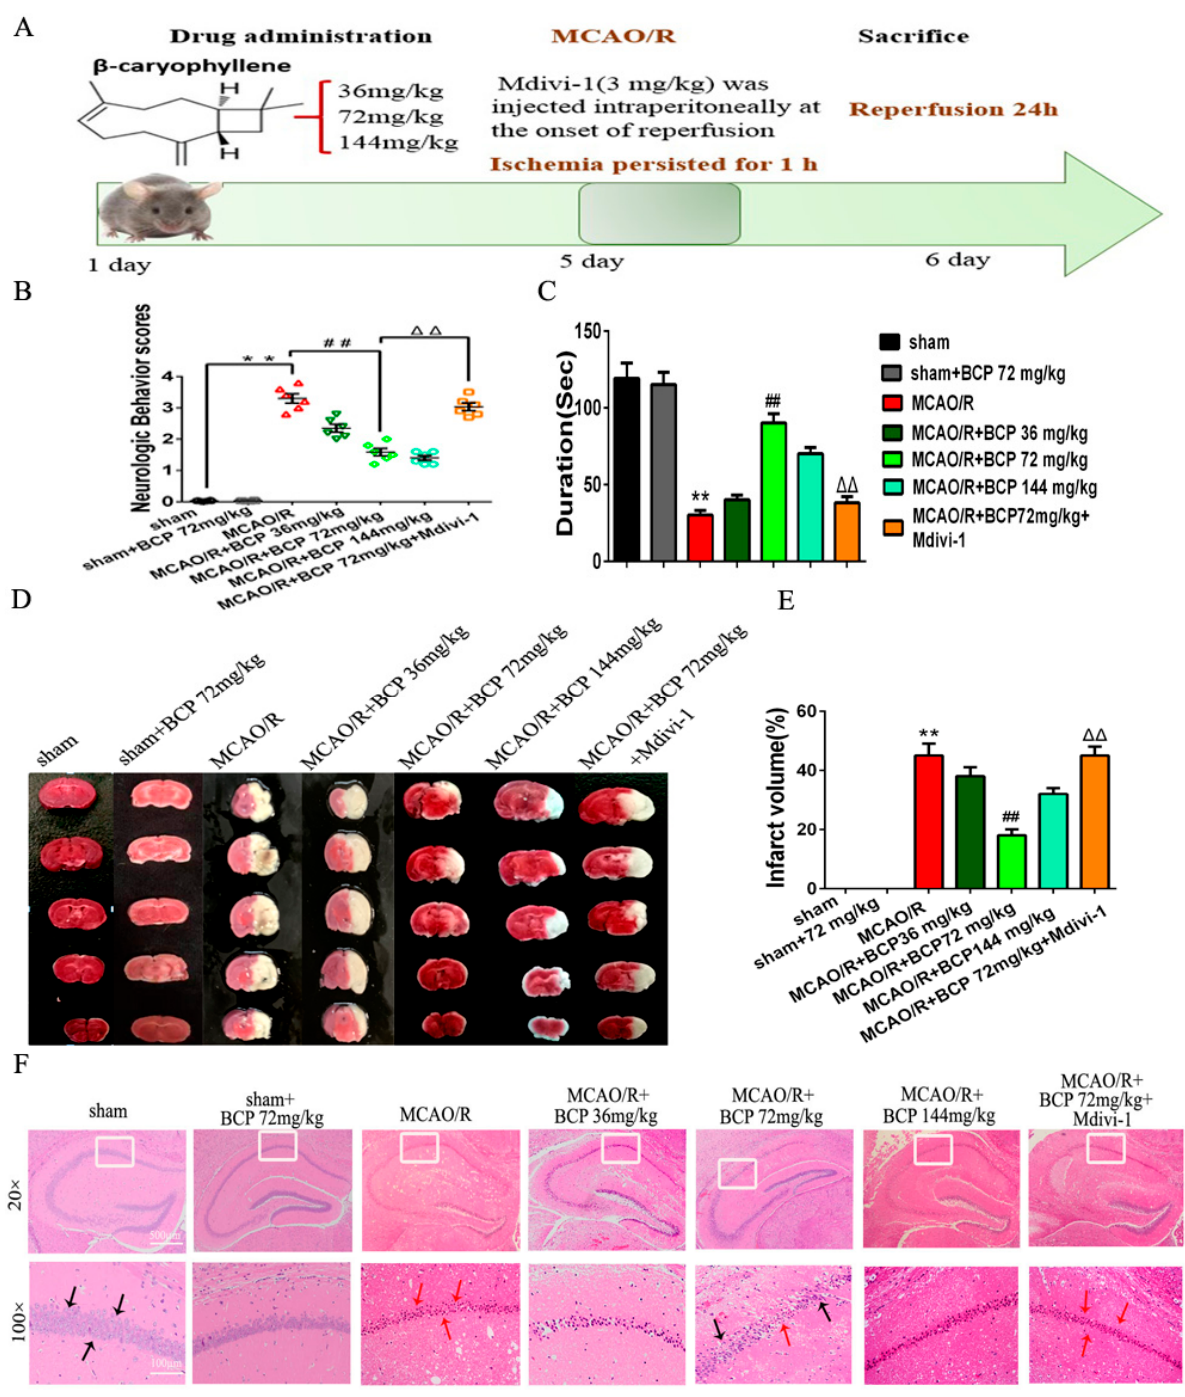
Figure 8. BCP protected against cerebral ischemia-reperfusion injury by facilitating mitophagy in C57BL/6 mice. ( A ) Schematic overview of experimental process. ( B ) Quantitative analysis of neurological function. ( C ) Duration of the rotarod test for all mice. ( D ) TTC staining of representative sections. ( E ) Quantification of infarcted volume. ( F ) H&E images of representative hippocampal CA1 sections of each group. (( A – F ), n = 6; ** p < 0.01 MCAO/R group vs. sham group; ## p < 0.01 MCAO/R + BCP group vs. MCAO/R group; (cid:52)(cid:52) p < 0.01 Mdivi-1 group vs. BCP